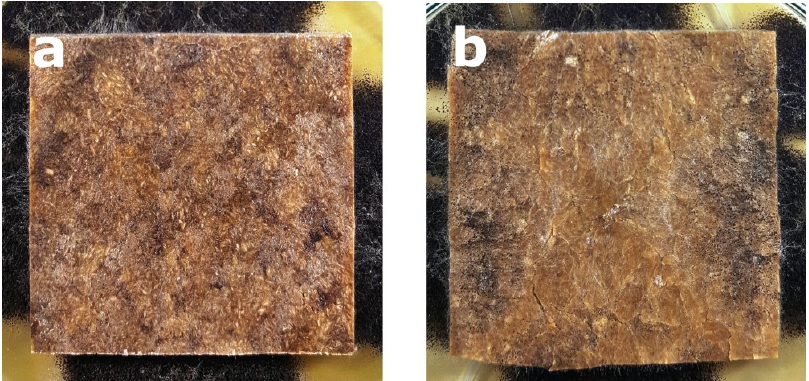
Figure 5. Example of mold growth ( Aspergillus niger Tiegh) after 7 days of exposure of composite samples with large particle sawdust filler of 60%, based on a matrix: ( a ) HDPE; ( b ) PLA. Application of the additives had a significant effect on the mold growth on both, PLA and HDPE composites (Figures 1a,d, 2a,d, 8 and 9). Irrespectively to the type of filler, the